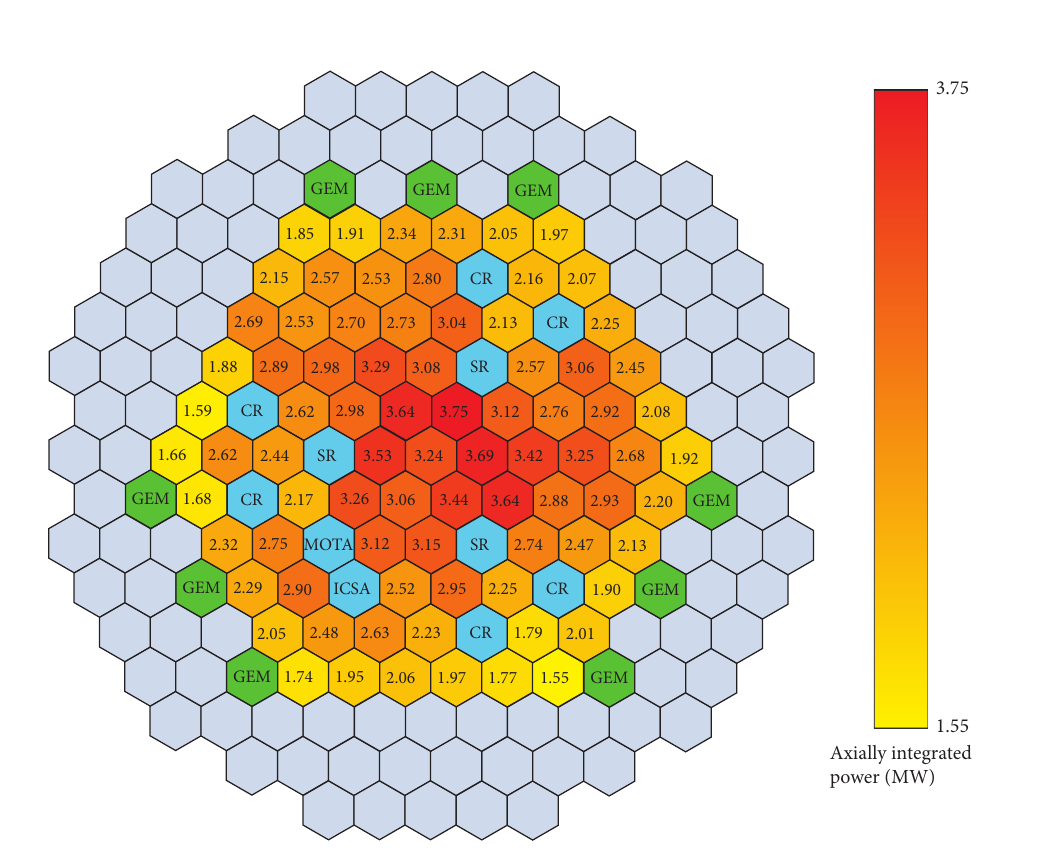
Figure 11: Power distribution map of FFTF